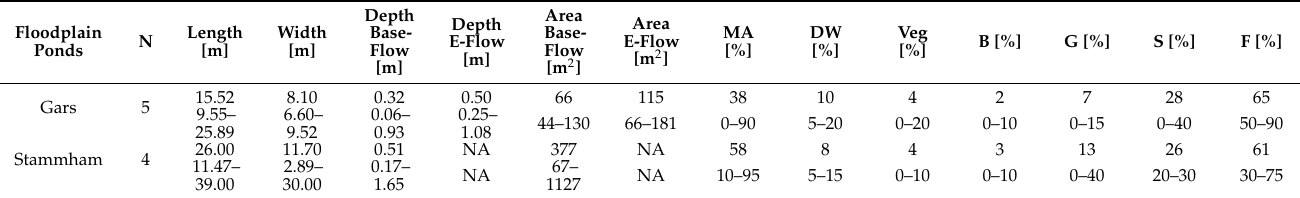
Table 3. Construction details of the constructed floodplain ponds in Gars and Stammham. Values represent the mean and the range. N = number of ponds, MA = submerged macrophytes in % coverage, DW = deadwood in % coverage, Veg = bank vegetation in % coverage. B = boulder in % coverage, G = gravel in % coverage, S = sand in % coverage, F = fines smaller 1 mm % coverage. NA = not